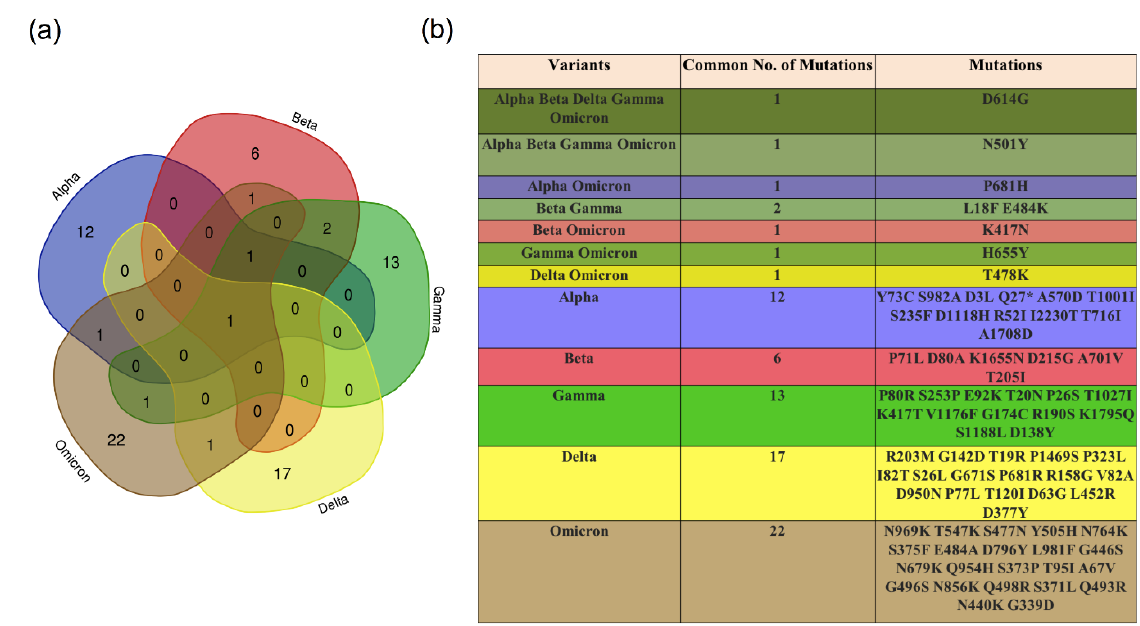
Figure 6. ( a ) Venn plot depicting the common spike glycoprotein mutations between the variant of concerns (VOCs) — Alpha, Beta, Gamma, Delta and Omicron. ( b ) the table showing the list of common spike glycoprotein mutations for the same. Figure has been drawn using Prism software. *: Found only in some of the sequenced alpha strain.